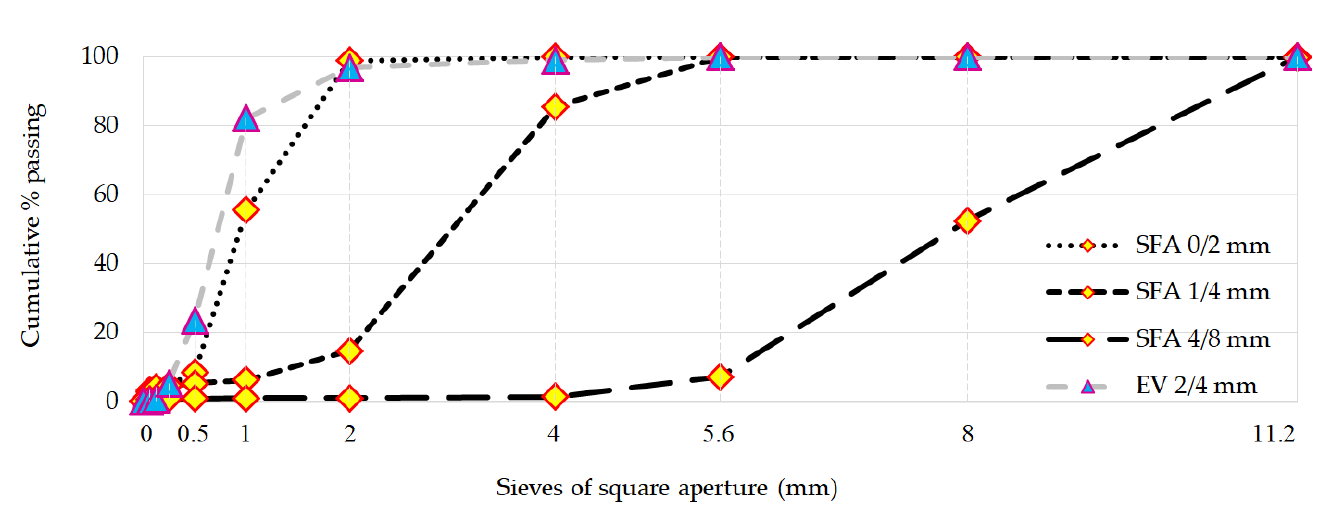
Figure 1 . SFA aggregate divided by fractions (from left: 0/2 mm; 1/4 mm and 4/8 mm).